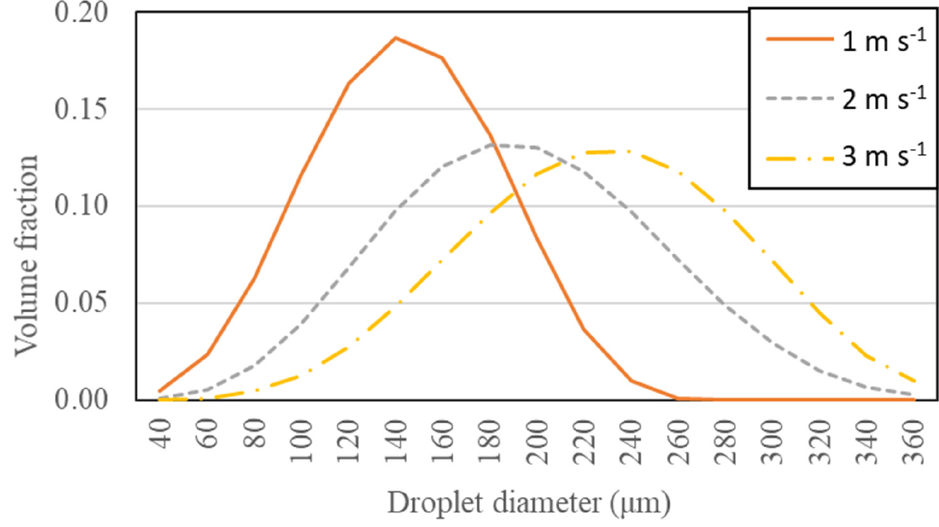
Figure 6. Airborne droplet size distribution fitted to the ULLN distribution according to wind speed.